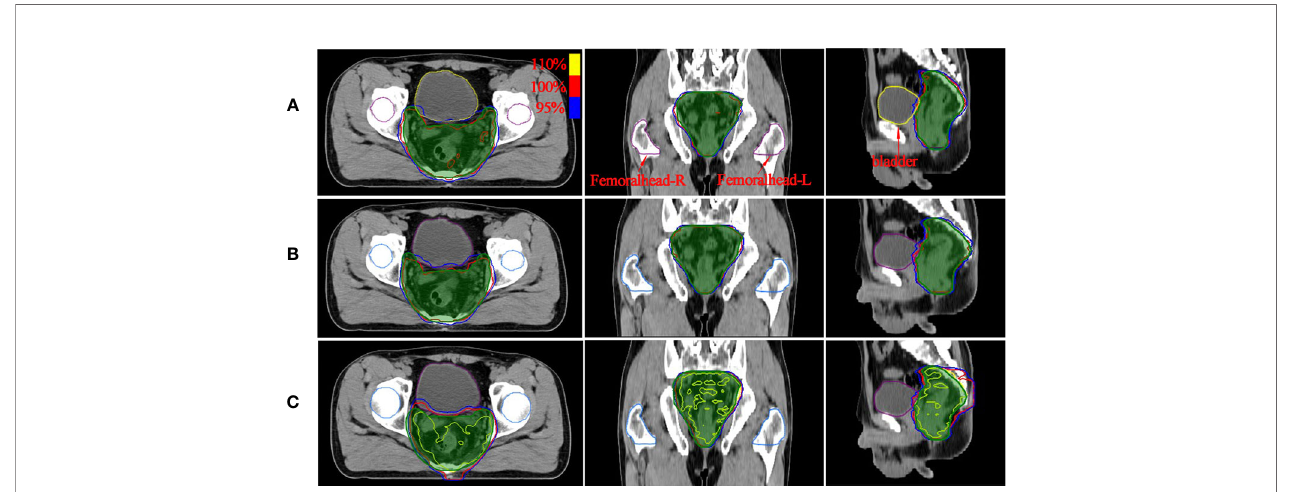
FIGURE 3 | The dose distribution comparison of PTV region (green shaded area) for two methods with manual plan: (A) manual plan, (B) dose prediction based post-optimization plan and (C) MSE optimization plan. The unit of color bar is